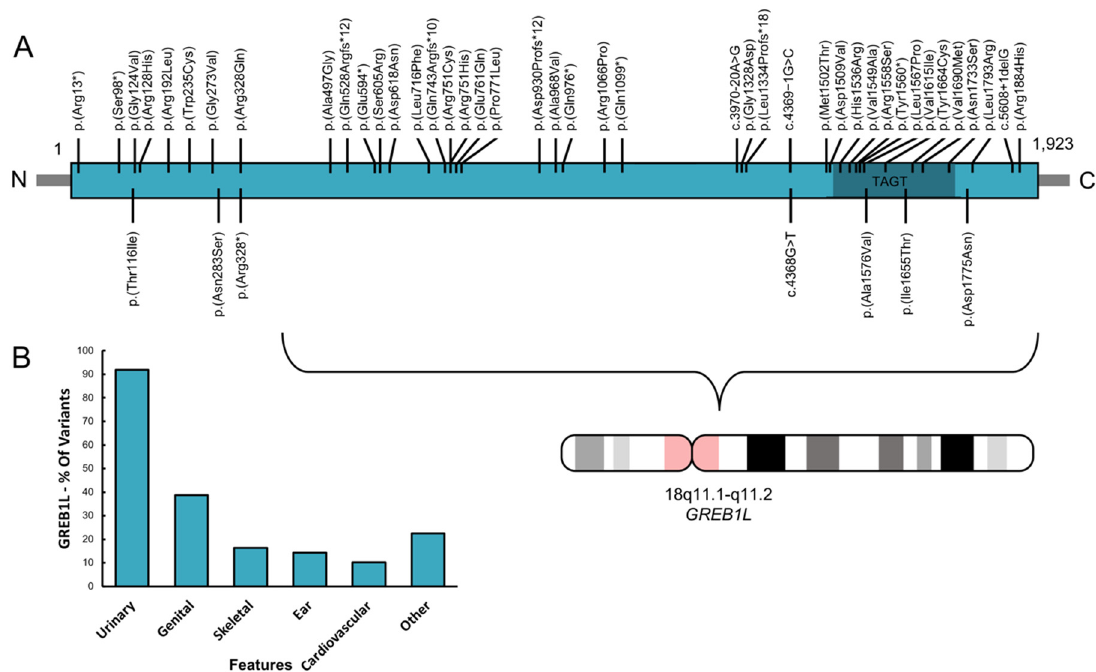
Figure 2. All variants reported in GREB1L and their associated phenotypic features. A . GREB1L protein structure with all variants indicated. The seven bottom variants are associated with ear-related abnormalities. Dark green, TAGT or Ten-eleven translocation / J binding protein (TET / JBP)-associated glycosyltrasferase domain [39]. B . The percentage (%) of variants associated with the most prevalent phenotypic features seen in affected individuals.